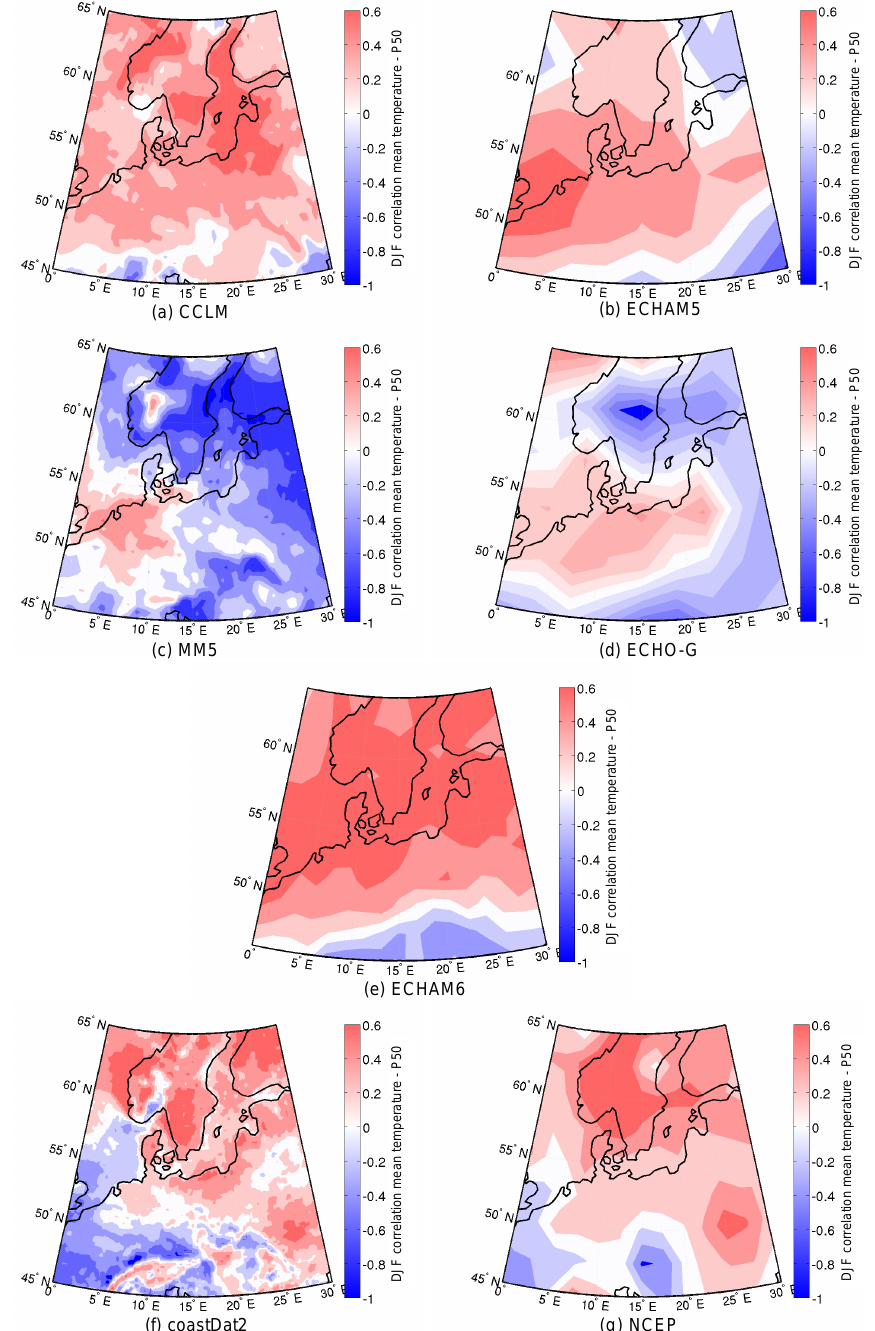
Figure 7. Correlation between field mean Temperature and 50th percentile of wind speed for seven different data sets in the overlapping time period from 1948 to 1990: (a) CCLM, (b) ECHAM5, (c) MM5, (d) ECHO-G, (e) ECHAM6, (f) coastDat2, (g) NCEP.